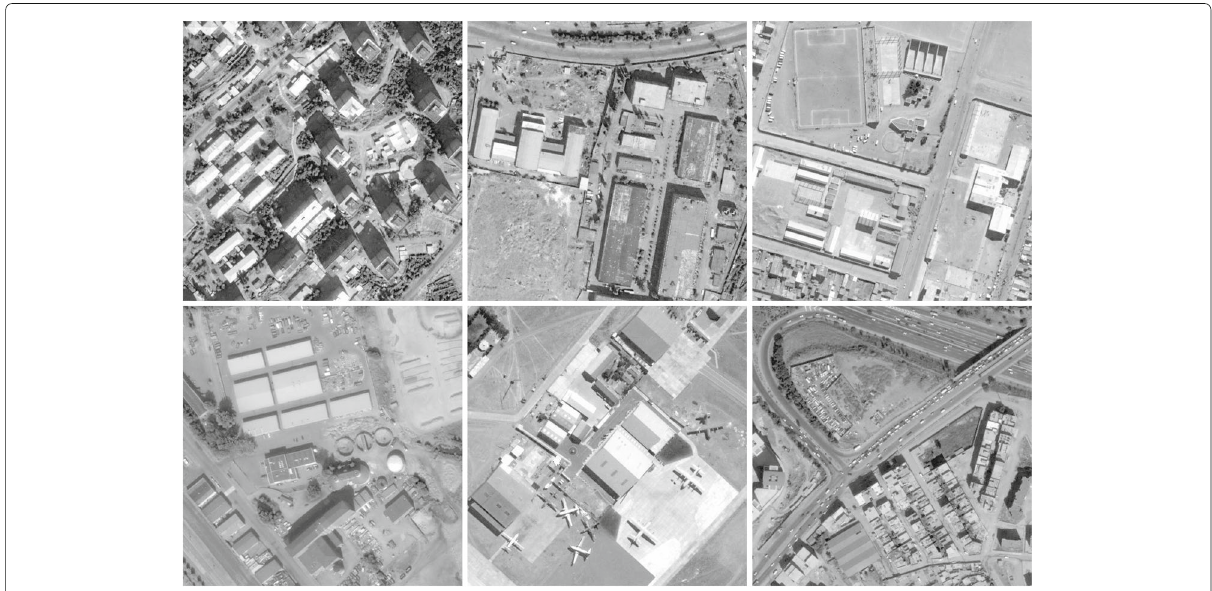
Fig. 27 Set of images used for testing the proposed rectangle detection method